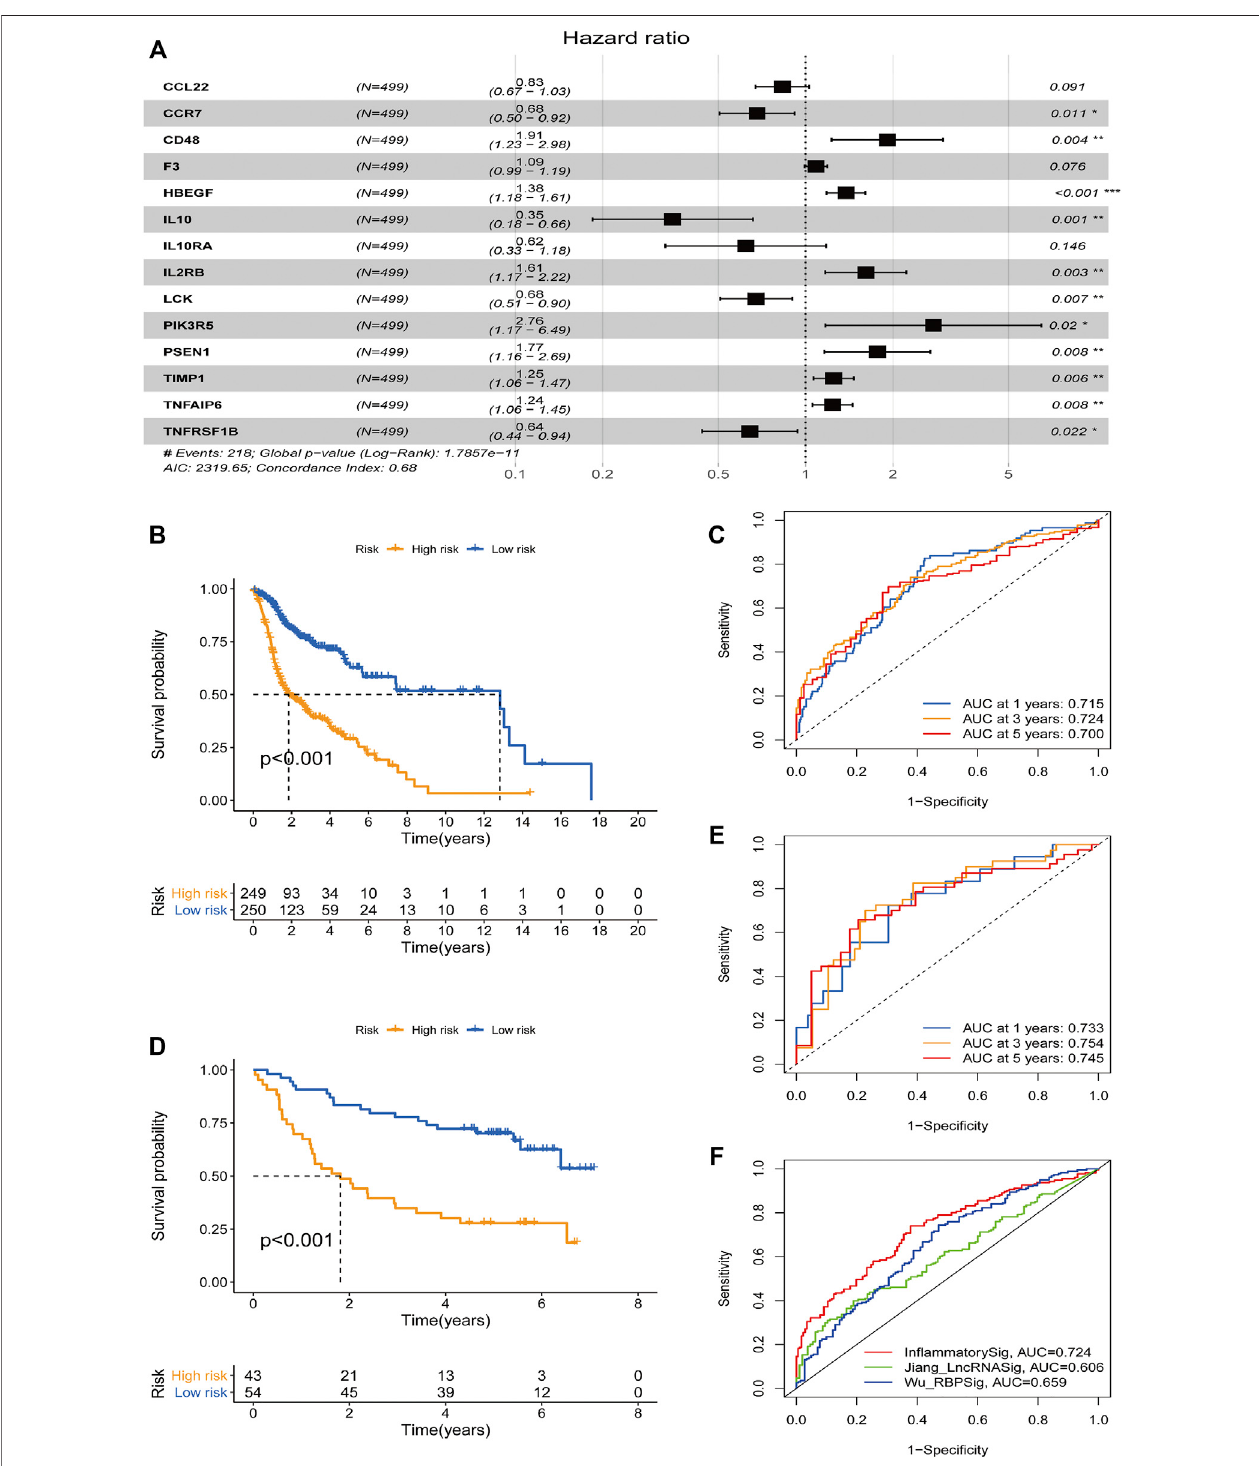
FIGURE 2 | Construction and prognostic analysis of the 14-gene signature model. (A) Forest plot showing 14 prognostic in fl ammatory response-related genes in head and neck squamous cell carcinoma based on a minimum Akaike information criterion (2319.65) value multivariate Cox results. * p < 0.05, ** p < 0.01, *** p < 0.001. HR < 1 means protective factors, HR > 1 means risk factors. Kaplan – Meier curve analysis of the in fl ammatory response – related gene signature in The Cancer Genome Atlas (TCGA) data set (B) and the Gene Expression Omnibus (GEO) data set (D) . Receiver operating characteristics (ROC) curve analysis of the in fl ammatory response – related gene signature of 1-, 3-, and 5-year in the TCGA data set (C) and GEO data set (E) . (F) A comparison of the 3-year ROC curve with Wu ’ s and Jiang ’ s models.